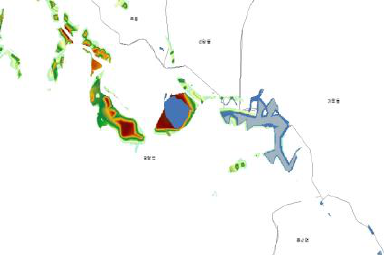
Figure 2. The Calculated Risk Hazard Element